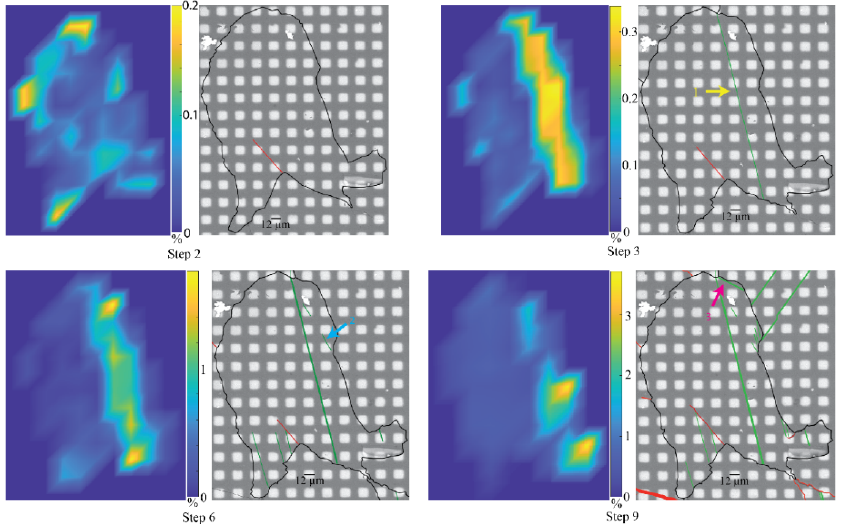
Figure 16. Equivalent Von Mises deformation map of crystal 9 at different steps of sample deformation. The black lines represent the grain boundaries. The green lines show the twinned planes. The red lines show the fracture